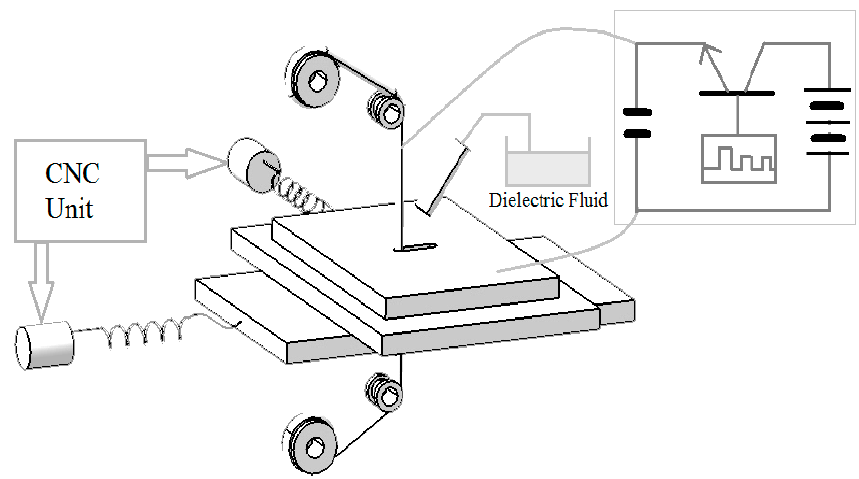
Figure 3. Wire electrical discharge machining process.